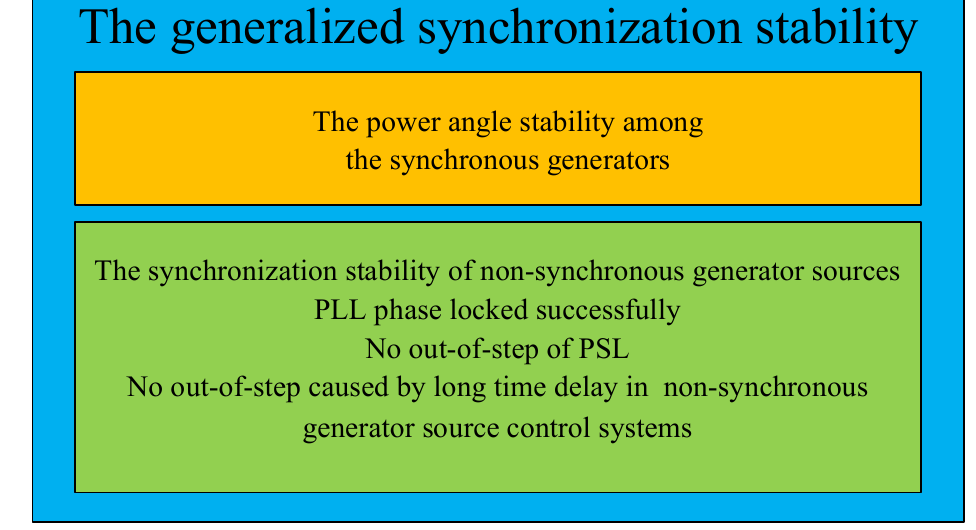
Figure 6. Relationship between the power angle stability and the generalized synchronization stability.